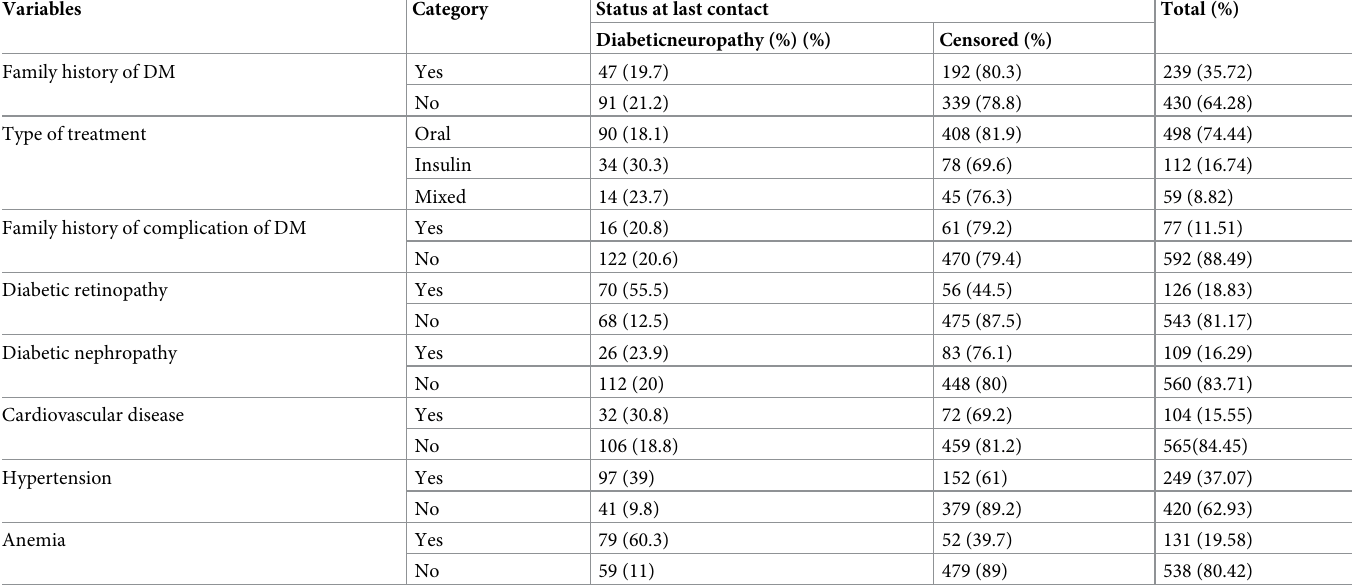
Table 2. Clinical and comorbidity characteristics of type 2 DM patients at Amhara region Comprehensive Specialized Hospital, Northwest Ethiopia (n = 669).